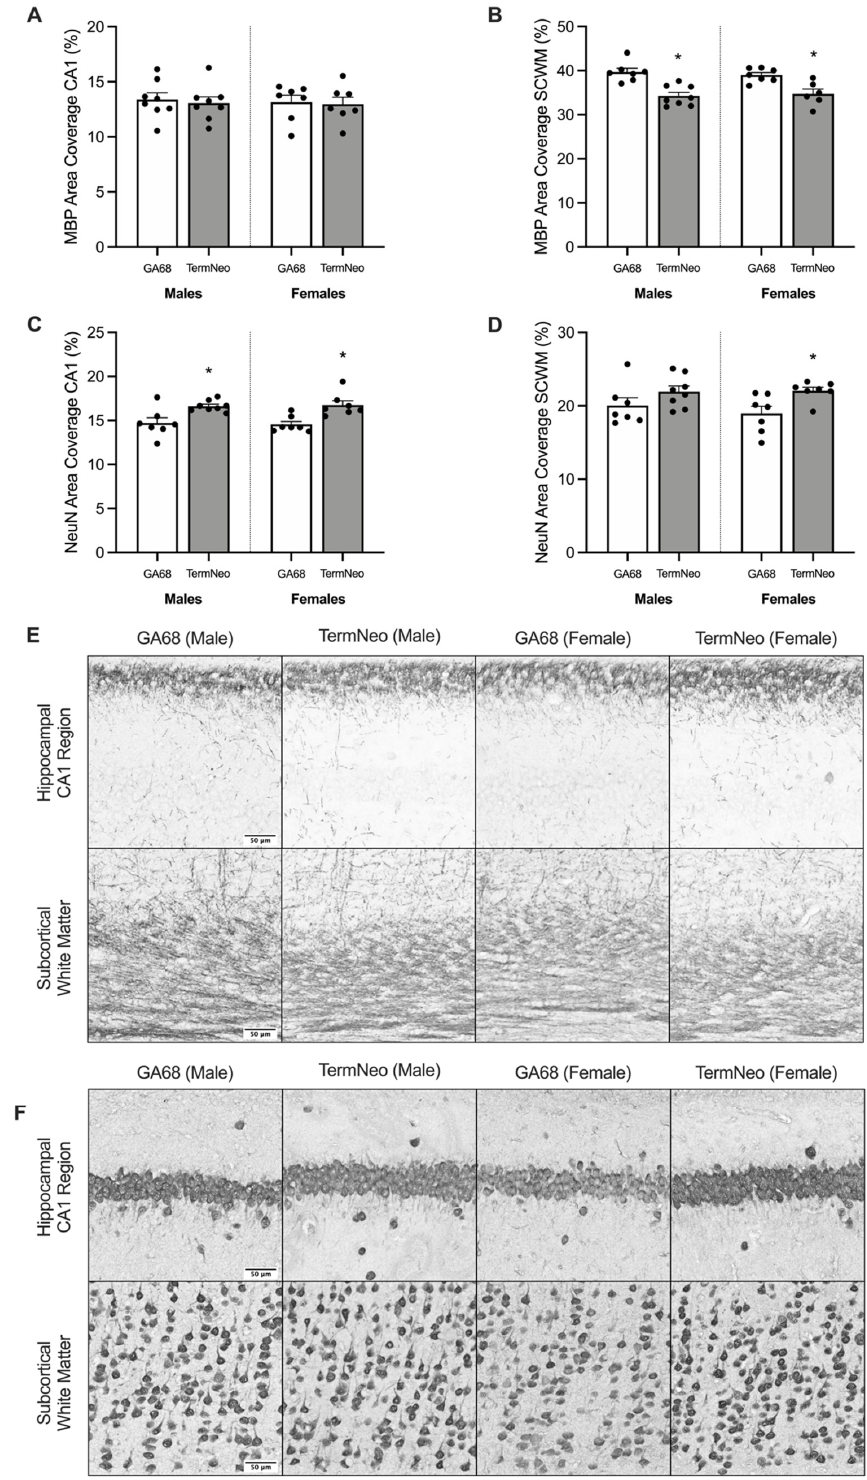
Figure 1. Myelin basic protein (MBP) and neuronal nuclei (NeuN) immunostaining was quantified in the brain of fetal GA68 (white; males n = 7, females n = 7) and term neonates (grey; males n = 8, females n = 7) for ( A , C ) the CA1 region of the hippocampus and ( B , D ) the overlying subcortical white matter. Data presented as means ± SEM with * indicating significance at p < 0.05. Representative photomicrographs of ( E ) MBP and ( F ) NeuN immunostaining of the CA1 region and overlying subcortical white matter. Scale bar = 50 µ